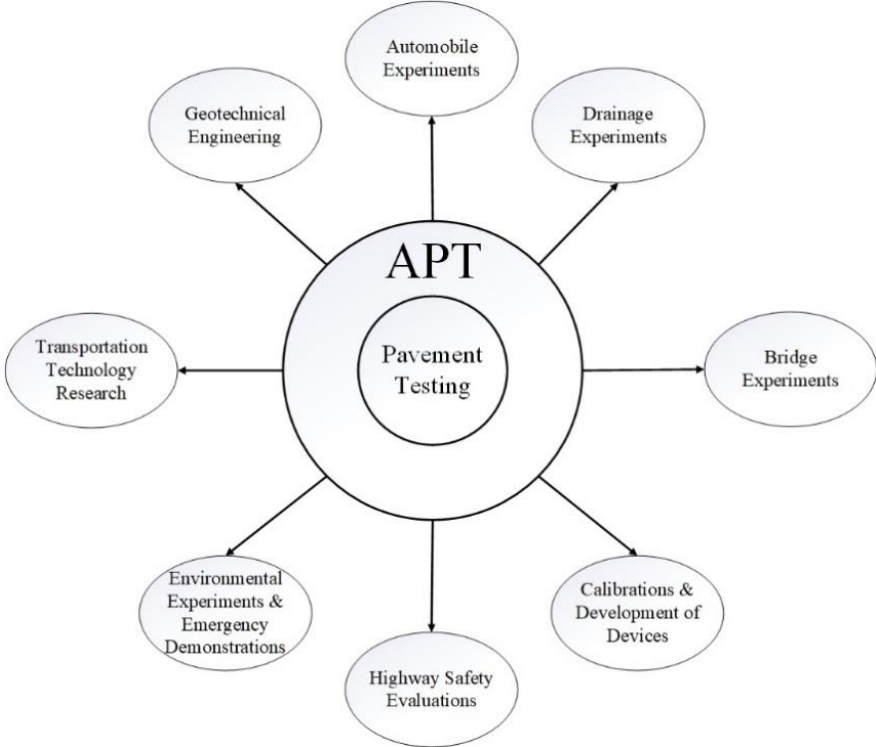
Figure 2. Schematic of pavement and non-pavement research applications of APT facilities.